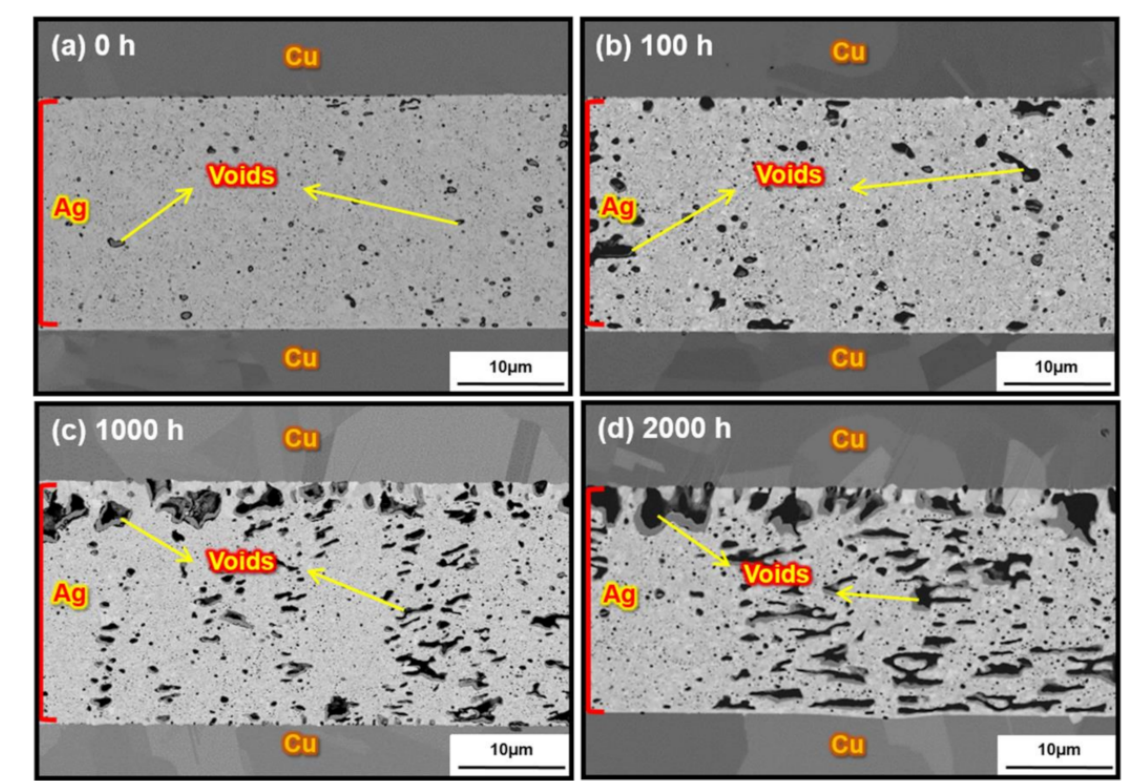
Figure 8. SEM images of the cross-section microstructure of the sintered Ag joints bonded at 10 MPa after HTS at 300 ◦ C for ( a ) 0 h, ( b ) 100 h, ( c ) 1000 h, and ( d ) 2000